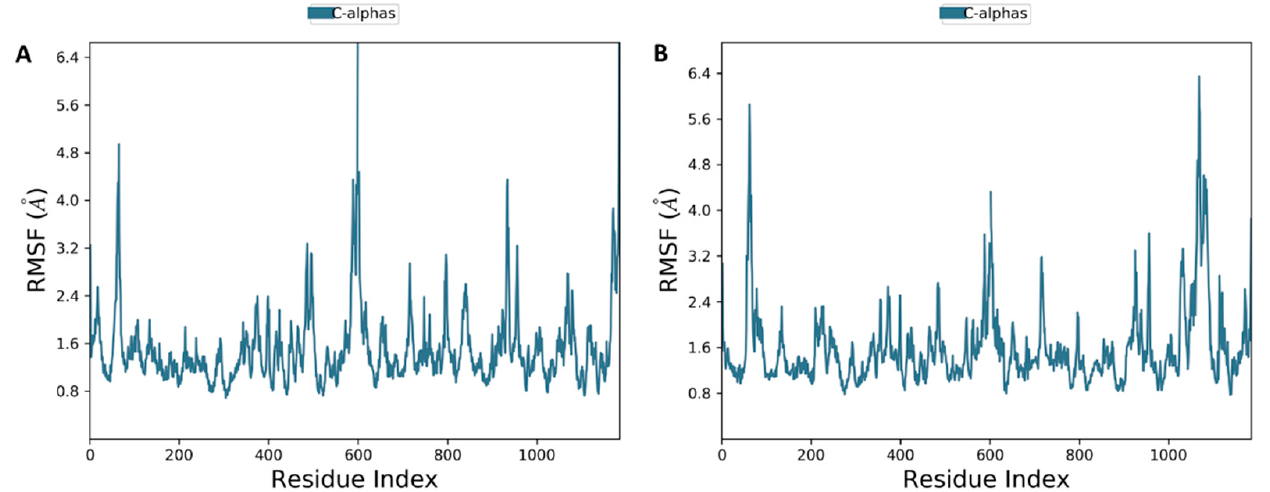
Figure 11. Root mean square fluctuations of the C α atom during the 100 ns molecular dynamic simulation. The ligand contact with protein residues is marked with blue-colored vertical bars compound 7 ( A ) and 8 ( B ).